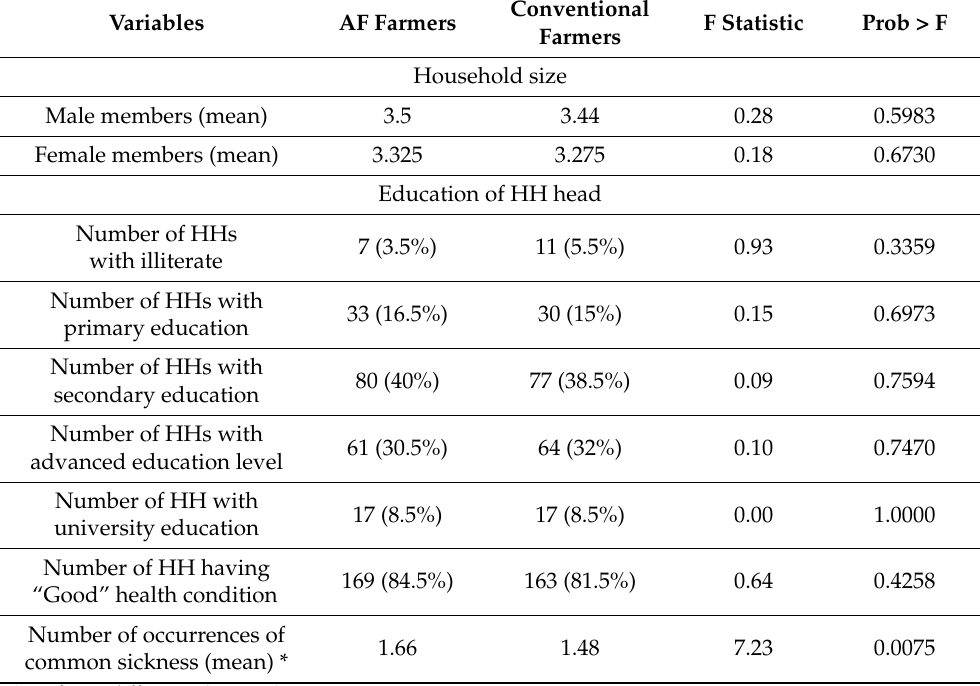
Table 6. Comparative analysis of the human capital of AF and CF famers.